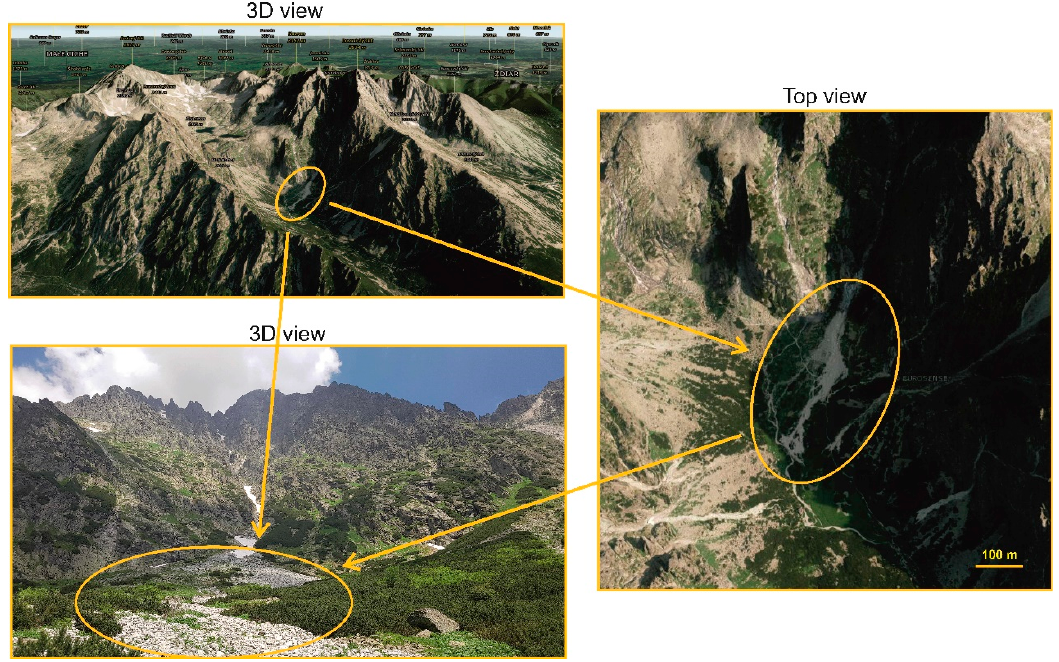
Figure 2. Location of the talus cone’s accumulation zone in the Small Cold Valley in the High Tatras, Slovakia.